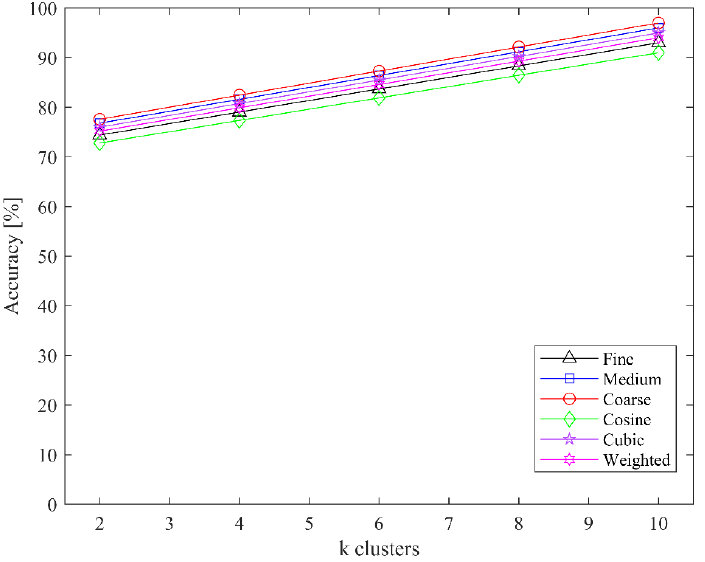
Figure 9. Classification accuracy of kNN for different values of k clusters.